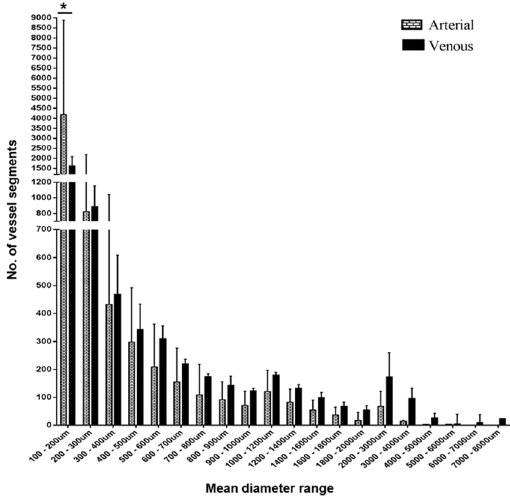
Figure 2. The number of vessel segments in different diameter ranges in the normal arterial and venous casts. There were more vessels (arterial and venous) in the smallest diameter group. The number of vessel segments declined progressively from the smallest to the largest diameter ranges. There were significantly fewer segments within the 100–200 µ m diameter range in the venous compared to the arterial casts. Median + Interquartile range of n = 12 (6 arterial, 6 venous) casts shown. Two-way RM Anova with Sidak’s multiple comparison test. Alpha value = 0.05, * marks two-tailed p value = 0.0001.